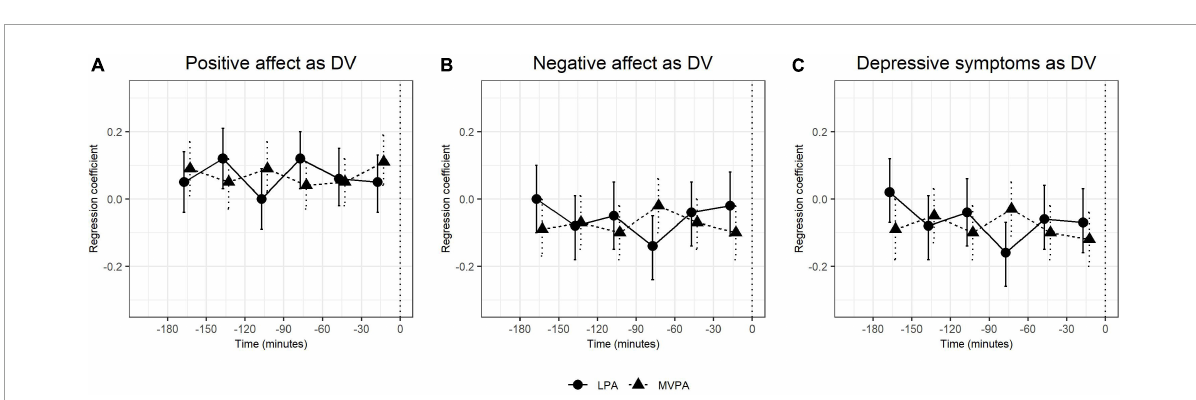
FIGURE2 The regression coefficients and confidence intervals of applying isotemporal substitution models in multilevel models in which light physical activity (LPA), moderate-to-vigorous physical activity (MVPA), and total physical activity (not reported) predicted subsequent positive affect (A) , negative affect (B) , and depressive symptoms (C) in all participants (unstratified). To facilitate better interpretation, the regression coefficients were multiplied by 10 (thus an unstandardized regression coefficient of 0.20 means that with every 10-min increase of the respective intensity of physical activity, the dependent variable increases by 20% of a standard